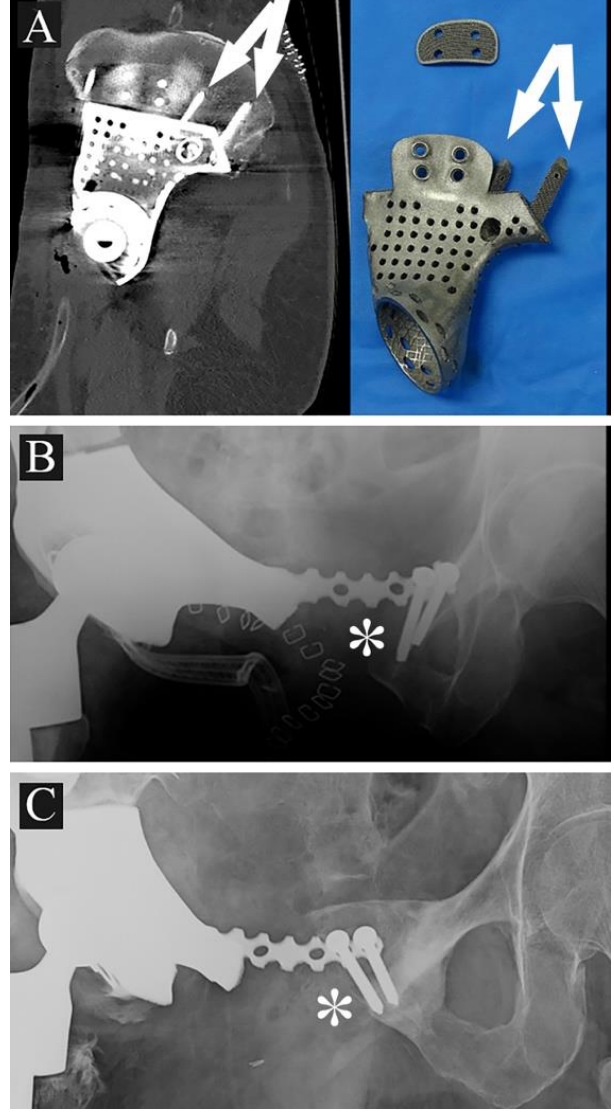
Figure 7. ( A ) 3DPTCMP with double iliac stem (white arrows) (case 9); ( B ) 3DPTCMP with connection to residual symphysis (white asterisk); ( C ) the same connection showed in ( B ) displaying mobilization and osteolysis (white asterisk).